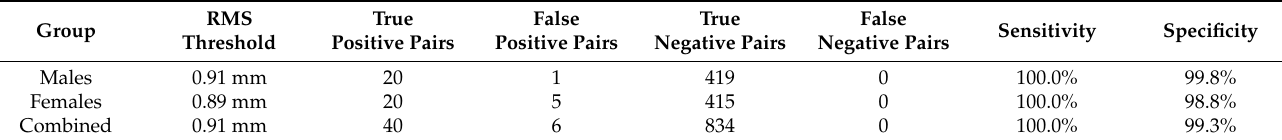
Table 2. Sorting performance of the method according to the chosen threshold.